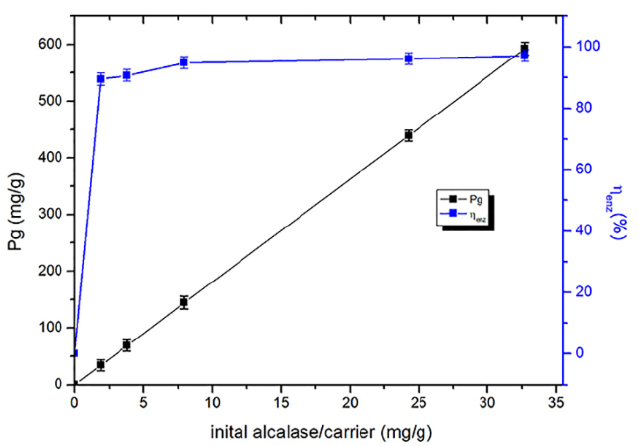
Figure 3. Effects of the initial alcalase/carrier ratio on the protein loading (P g ) and enzyme coupling yield (η enz ).